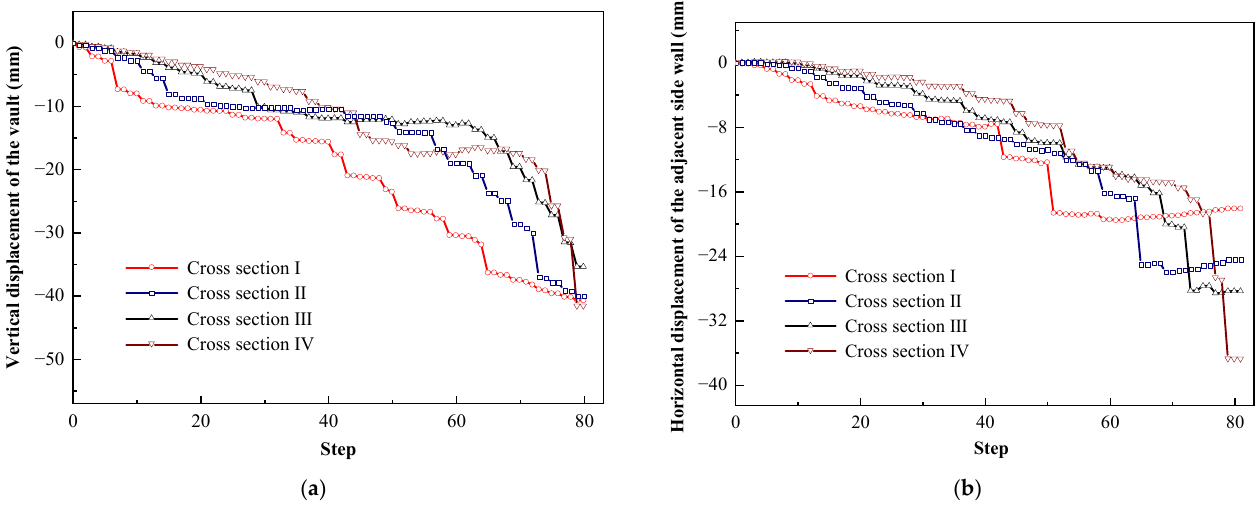
Figure 8. Displacement of new constructing tunnel. ( a ) Vertical displacement of the vault; ( b ) horizontal displacement of the adjacent side wall.